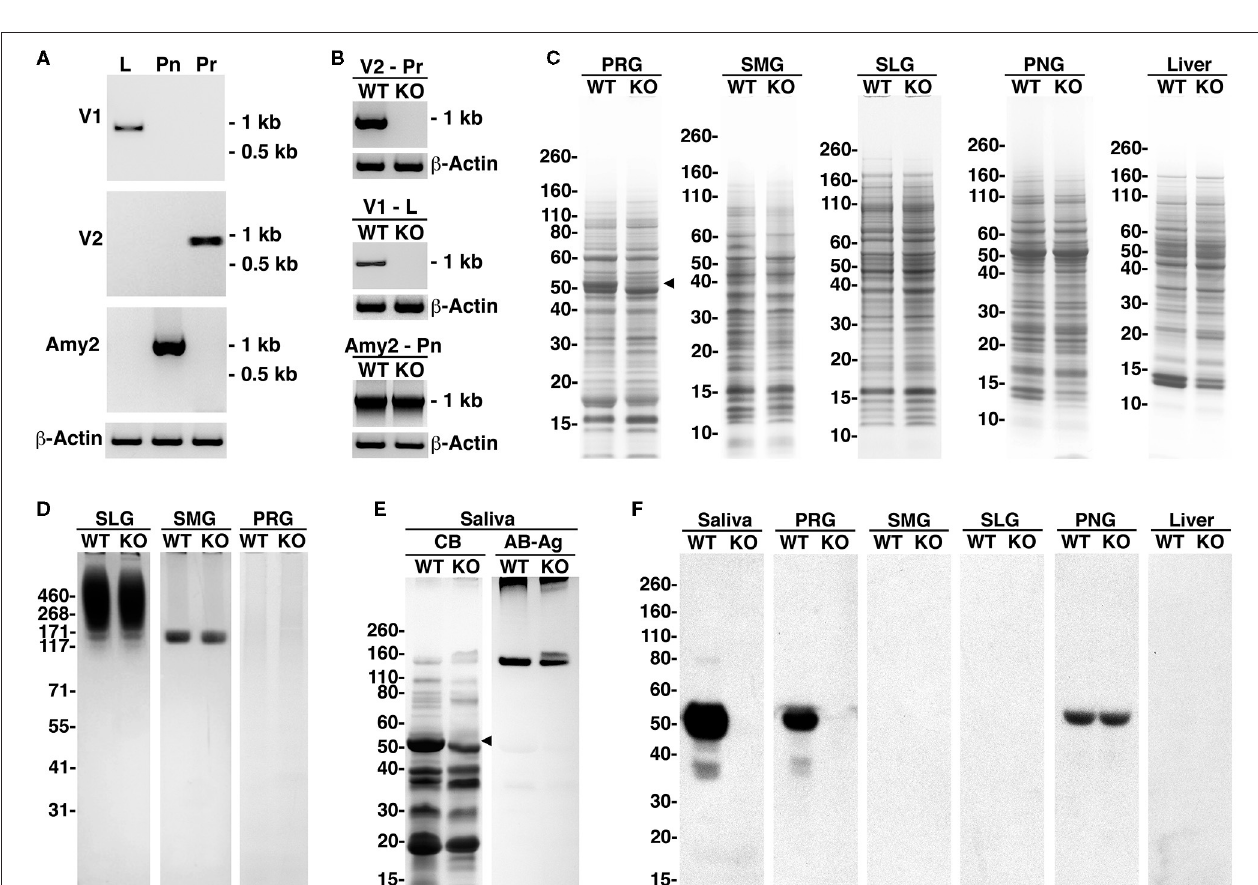
FIGURE 3 | Amylase transcripts, amylase proteins, and whole tissue protein profiles of major salivary glands, pancreas, and liver and of saliva from wild-type (WT) and Amy1 knockout (KO) mice. (A) Expressions in WT mice of transcripts for the V1 and V2 isoforms of Amy1 and of Amy2 in liver ( L ), parotid glands ( Pr ), and pancreas ( Pn ), respectively. (B) Expressions of amylase transcripts in Pr, L, and Pn of WT and KO mice. (C) Comparisons between WT and KO mice of the whole tissue protein profiles from parotid glands ( PRG ), submandibular glands ( SMG ), sublingual glands ( SLG ), pancreatic gland ( PNG ), and liver. The black triangle indicates an ∼ 50-kDa band absent in the parotid glands of KO mice. SDS-PAGE 4–12% gels stained with Coomassie blue. (D) Expressions of highly glycosylated Muc19 mucin glycoproteins in sublingual glands and Muc10 mucins in submandibular glands were similar between WT and KO mice, whereas highly glycosylated glycoproteins were undetected in the parotid glands of mice of either genotype. SDS-PAGE 3–8% gel stained with Alcian blue and subsequent silver enhancement. (E) Whole stimulated saliva (6.5 µ l) from WT and KO mice in an SDS-PAGE 10% − 20% gradient gel stained with Coomassie blue ( CB ) or stained for glycoproteins with Alcian blue ( AB ) and subsequent enhancement with silver ( Ag ). The black triangle indicates an ∼ 50-kDa protein band absent in KO saliva. (F) Western blots probing for amylase in saliva (15 µ l) or tissue samples (200 µ g wet weight) from WT and KO mice and run on 4% − 12% SDS-PAGE gels.